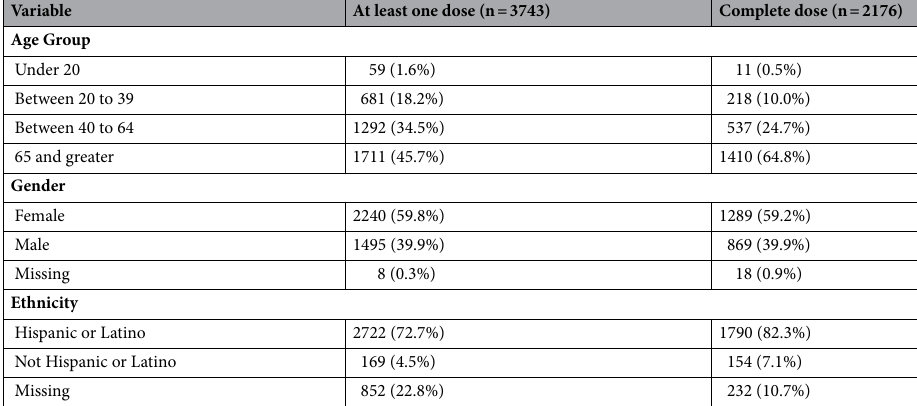
Table 1. Summary of COVID-19 vaccination in City of Brownsville between February 5th, 2021 (COVID- 19 vaccination first became available to the region) and March 13th, 2021. At least one dose refers to either completing one or two doses of Moderna mRNA-1273 COVID-19 vaccine, or one dose of Janssen (Ad.26. COV2.S) vaccine. Complete dose refers to either completing two doses of Moderna mRNA-1273 COVID-19 vaccine, or one dose of Janssen (Ad.26.COV2.S)